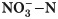
Content (%) of NO3‐‑N and NH4+‑N during composting at different turning frequencies.Error bars represent the standard deviations of the means (n = 3).